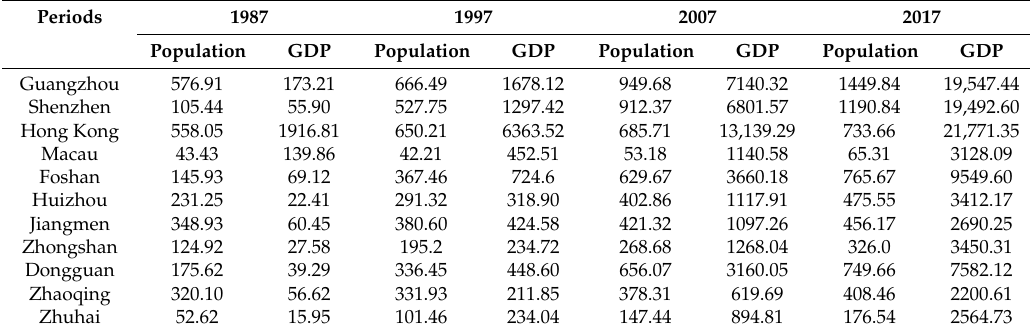
Table 3. Information on the gross domestic product (GDP) and population of the 11 cities within the Greater Bay Area